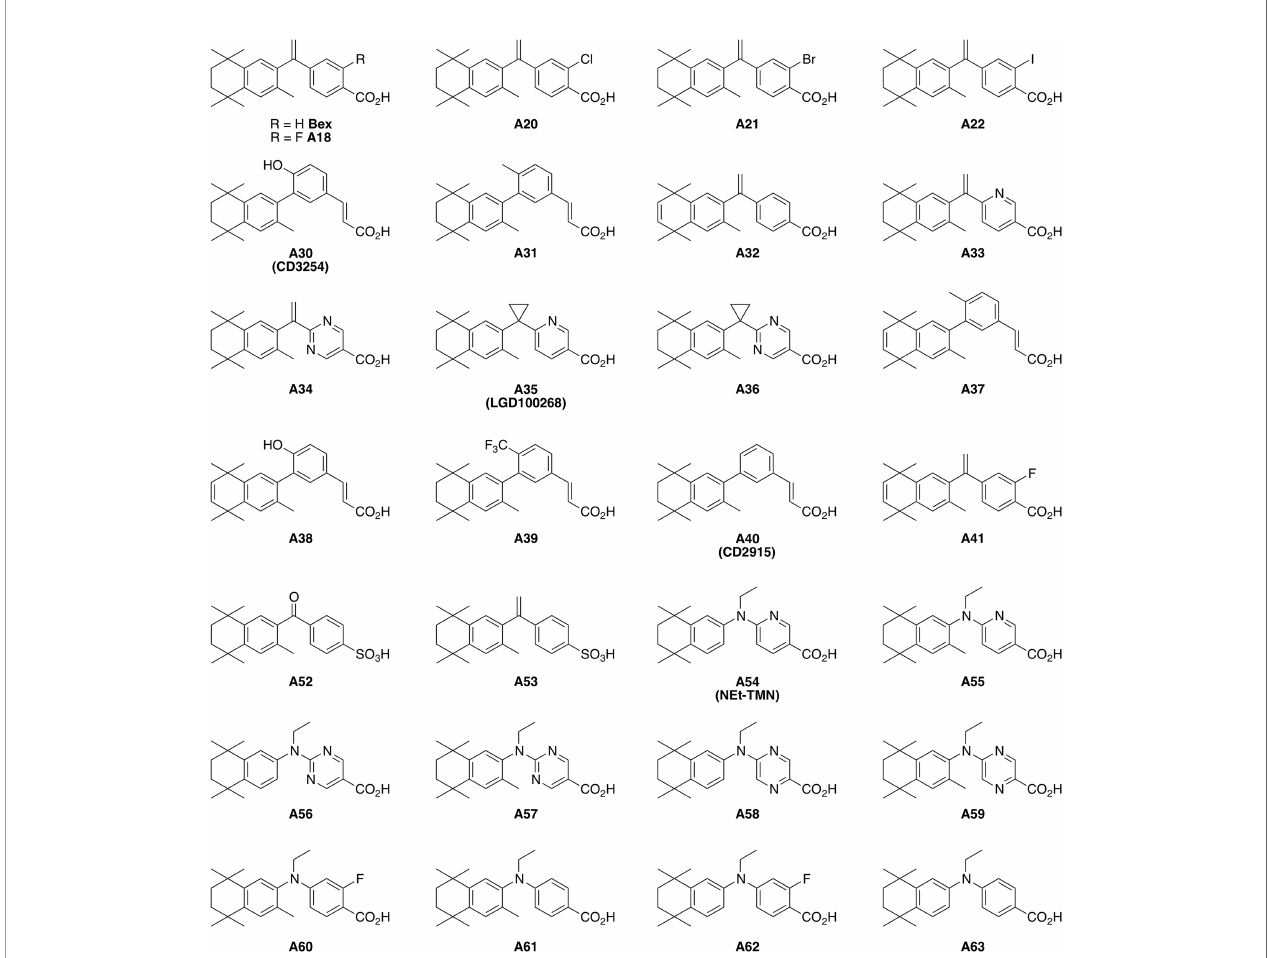
FIGURE 1 | Structures of select rexinoids from the tested panel of